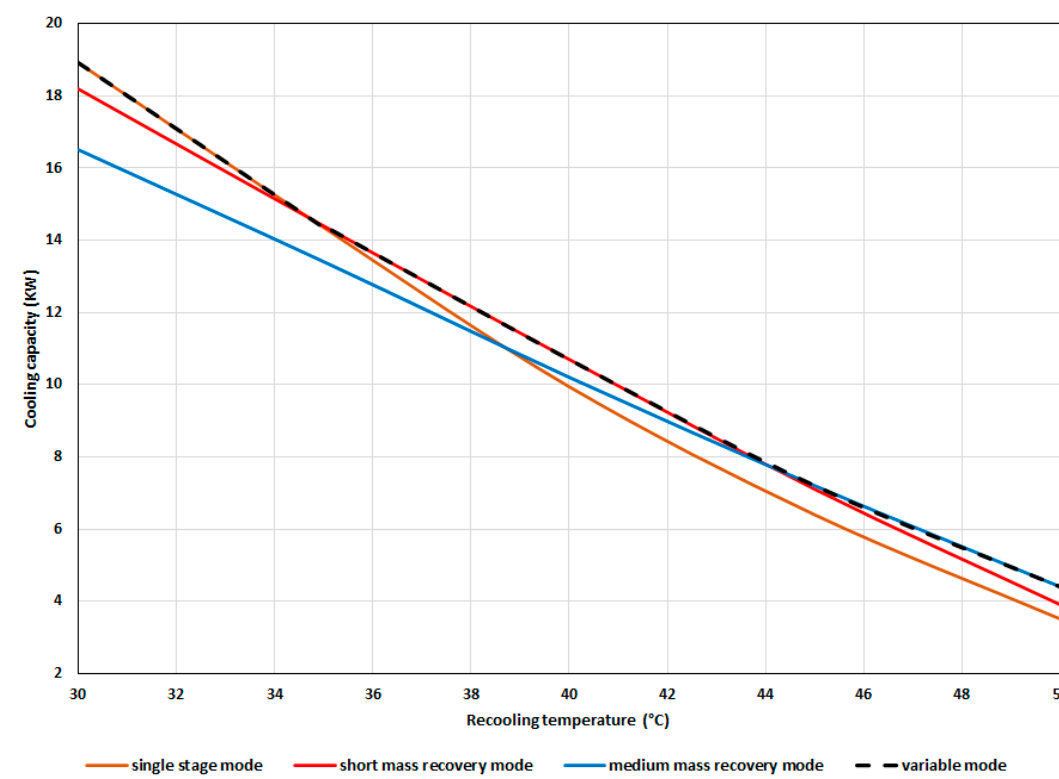
Figure 19. Predicted cooling capacity for various modes and recooling water temperatures.